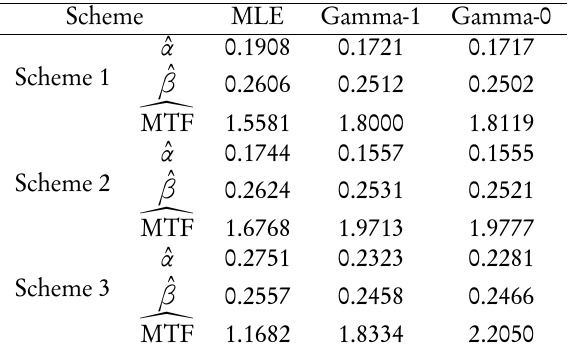
MLEs and Bayes estimates for real data set.